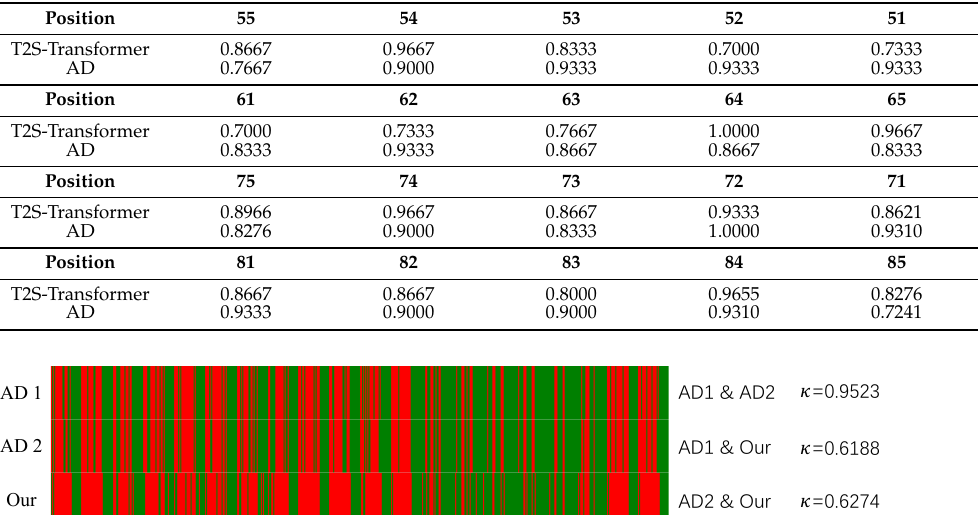
Table 4. Classification accuracy of each tooth for the proposed T2S-Transformer and two attending doctors (AD, average performance is reported).